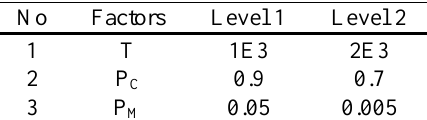
Table 1. Levels of DOE